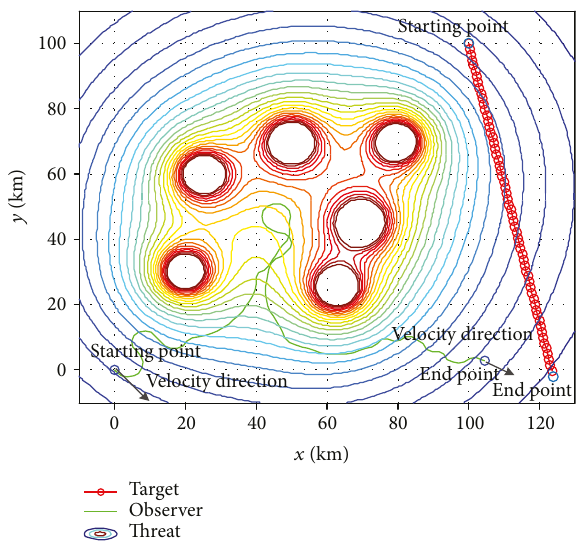
Figure 8: Moving target tracking in scenario 4(b).